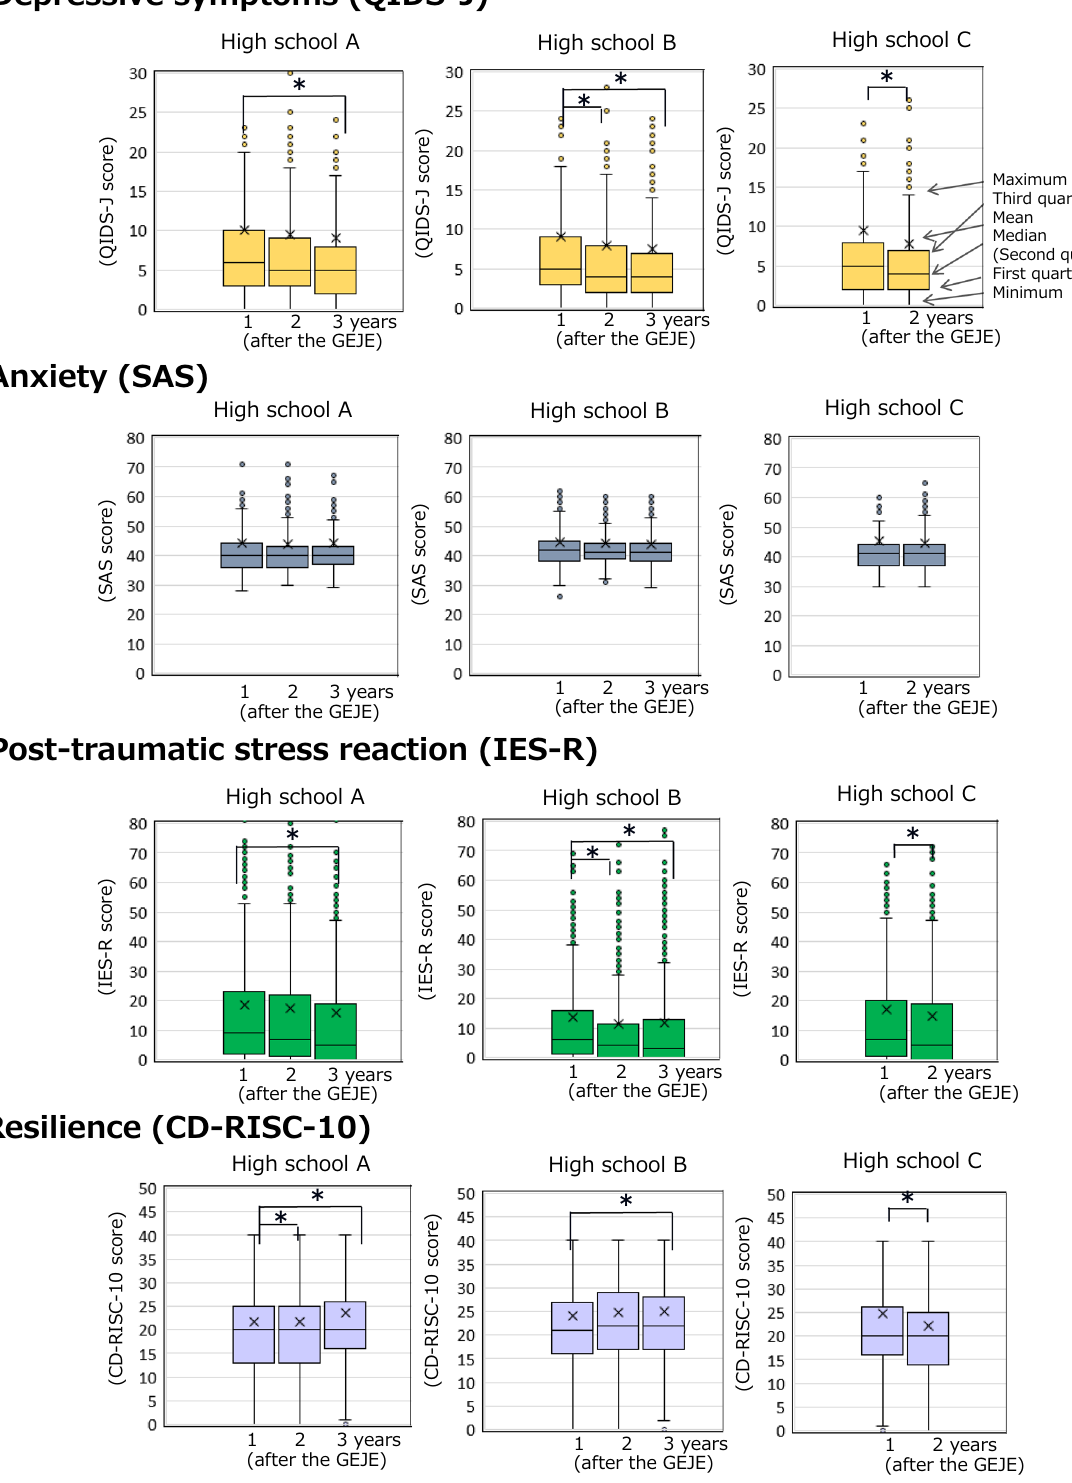
Fig. 3 Resilience and mental health indicators of students assessed in 2012 to 2013. QIDS-J Quick Inventory of Depressive Symptomatology — Japanese version, SAS Zung Self-Rating Anxiety Scale, IES-R Impact of Event Scale — Revised, CD-RISC-10 10-item Conner-Davidson Resilience Scale, GEJE, Great East Japan